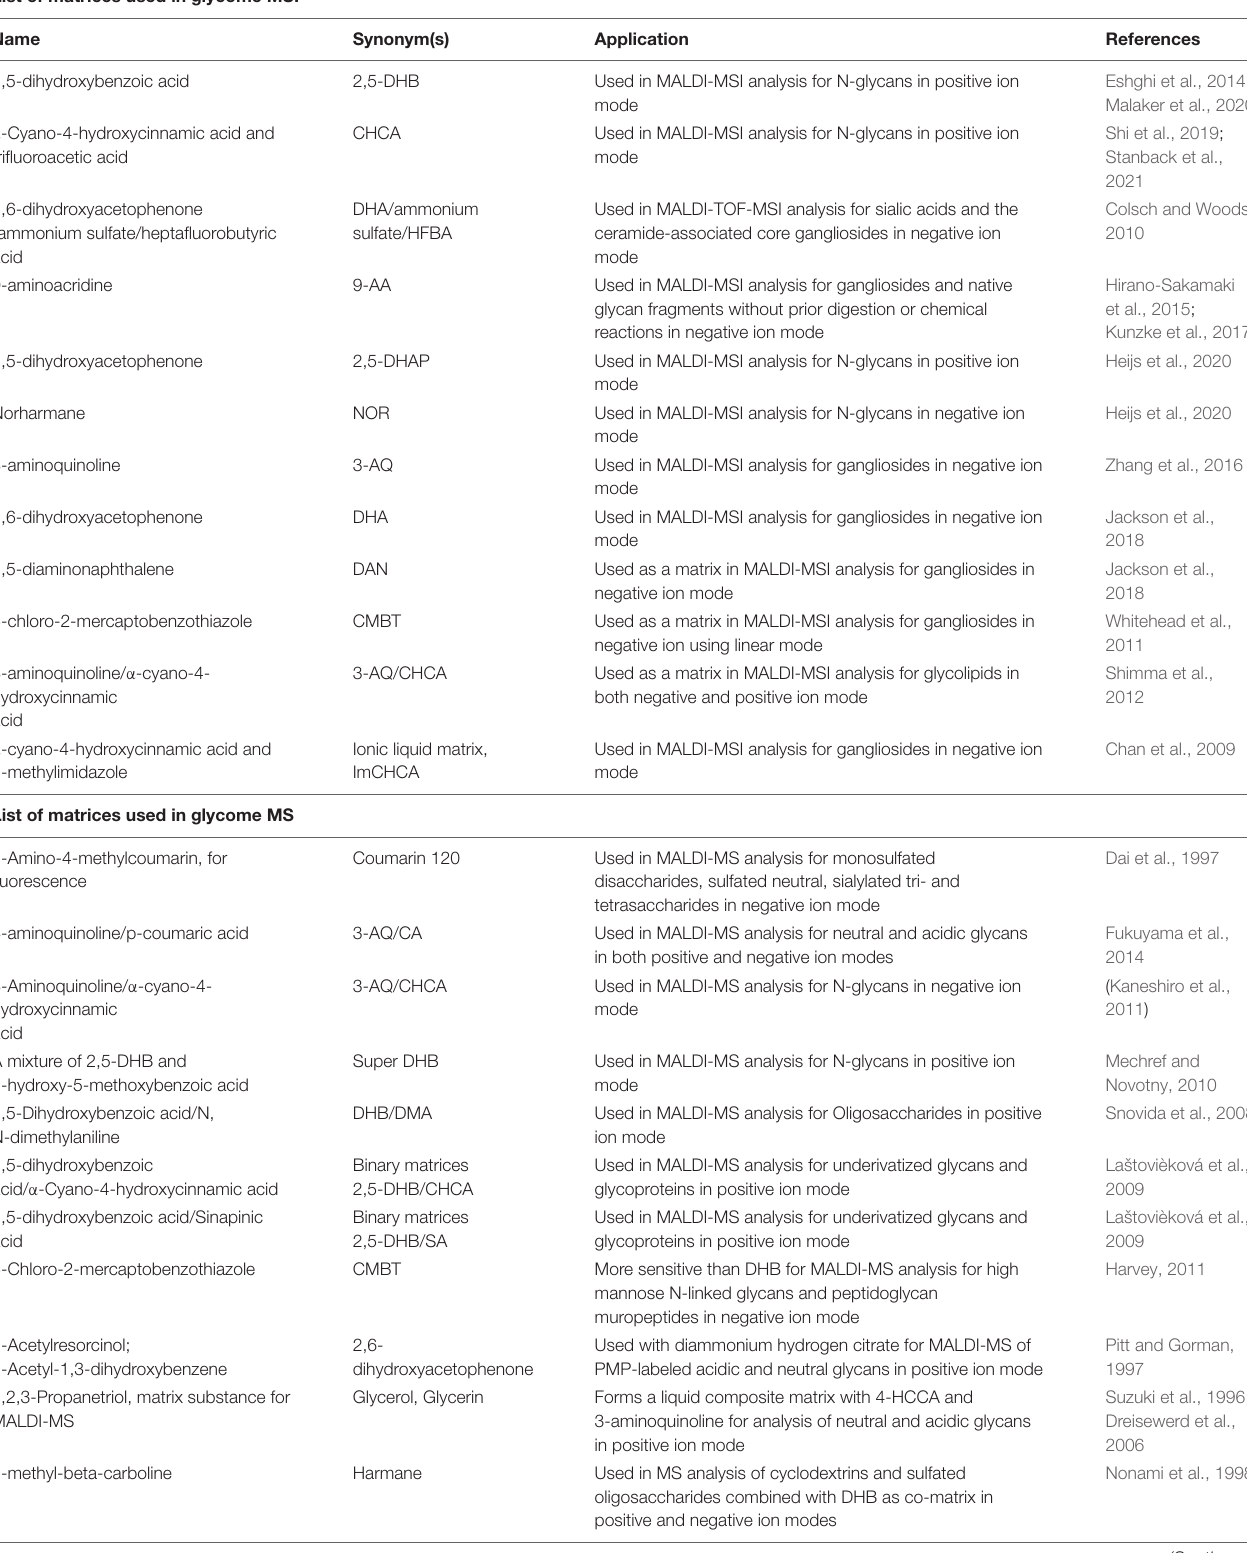
TABLE 2 | List of matrices used in glycome MSI and MS analysis. List of matrices used in glycome